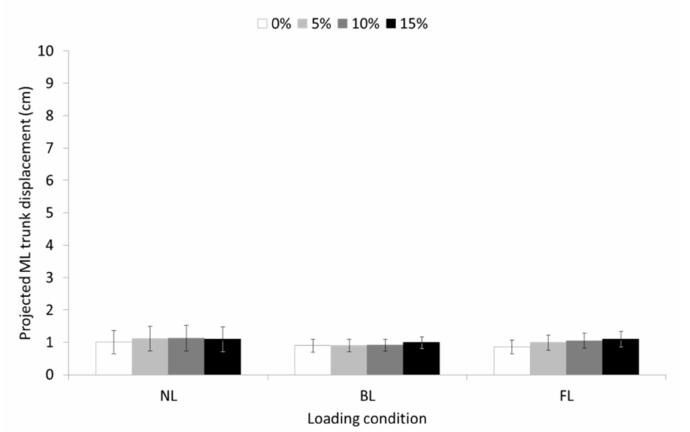
Figure 8. Means and 95% confidence intervals (error bars) for the projected mediolateral (ML) trunk displacement during unloaded (UL), back-loaded (BL), and front-loaded (FL) walking at 0 (level), 5, 10, and 15% uphill